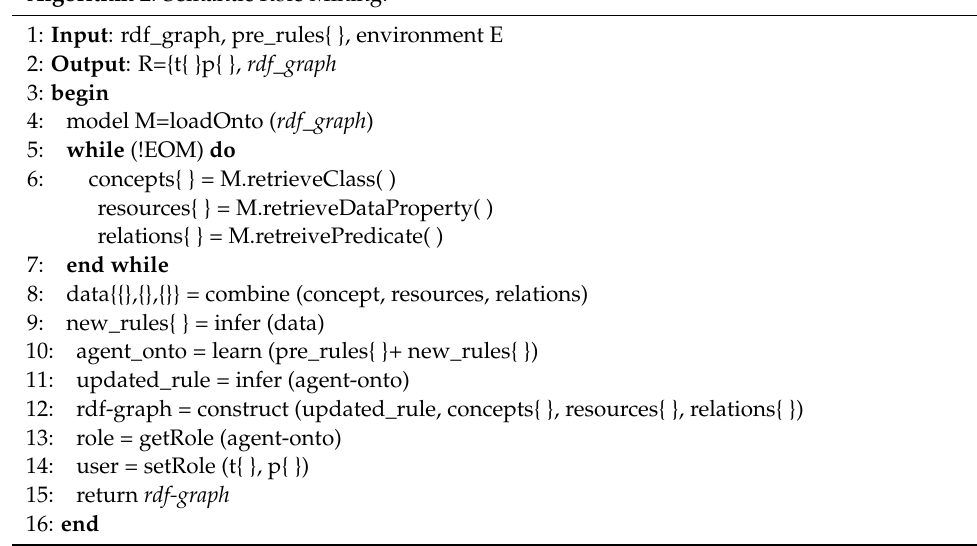
Algorithm 2 : Semantic Role